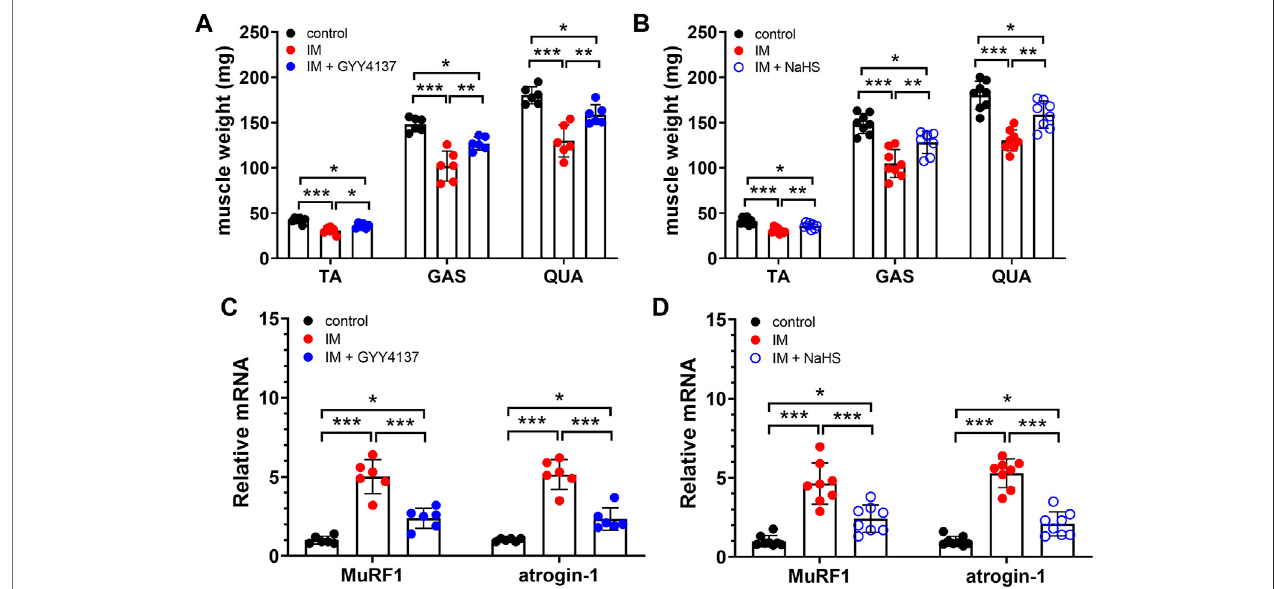
FIGURE 2 | H2S donors protect the IM-induced muscle loss and downregulate muscle atrophy-related genes expression. Mice were subjected to IM and treated with GYY4137 (a and c, 50 μ g/kg/d, ip), or NaHS (b and d, 1.12 mg/kg, twice a day, ip) for 2 weeks. The control and IM groups received identical doses of saline for 2 weeks. (A) , TA, GAS, and QUA muscle weights in control, IM, and IM + GYY4137 mice (n = 6 in each group). (B) , TA, GAS, and QUA muscle weights in control, IM, and IM + NaHS mice (n = 8 in each group). (C) , Expression of MuRF1 and atrogin-1 in TA muscles in control, IM, and IM + GYY4137 mice (n = 6 in each group). (D) , Expression of MuRF1 and atrogin-1 in TA muscles in control, IM, and IM + NaHS mice (n = 8 in each group). Data represent means ± SEM. * p < 0.05, ** p < 0.01, *** p < 0.001.